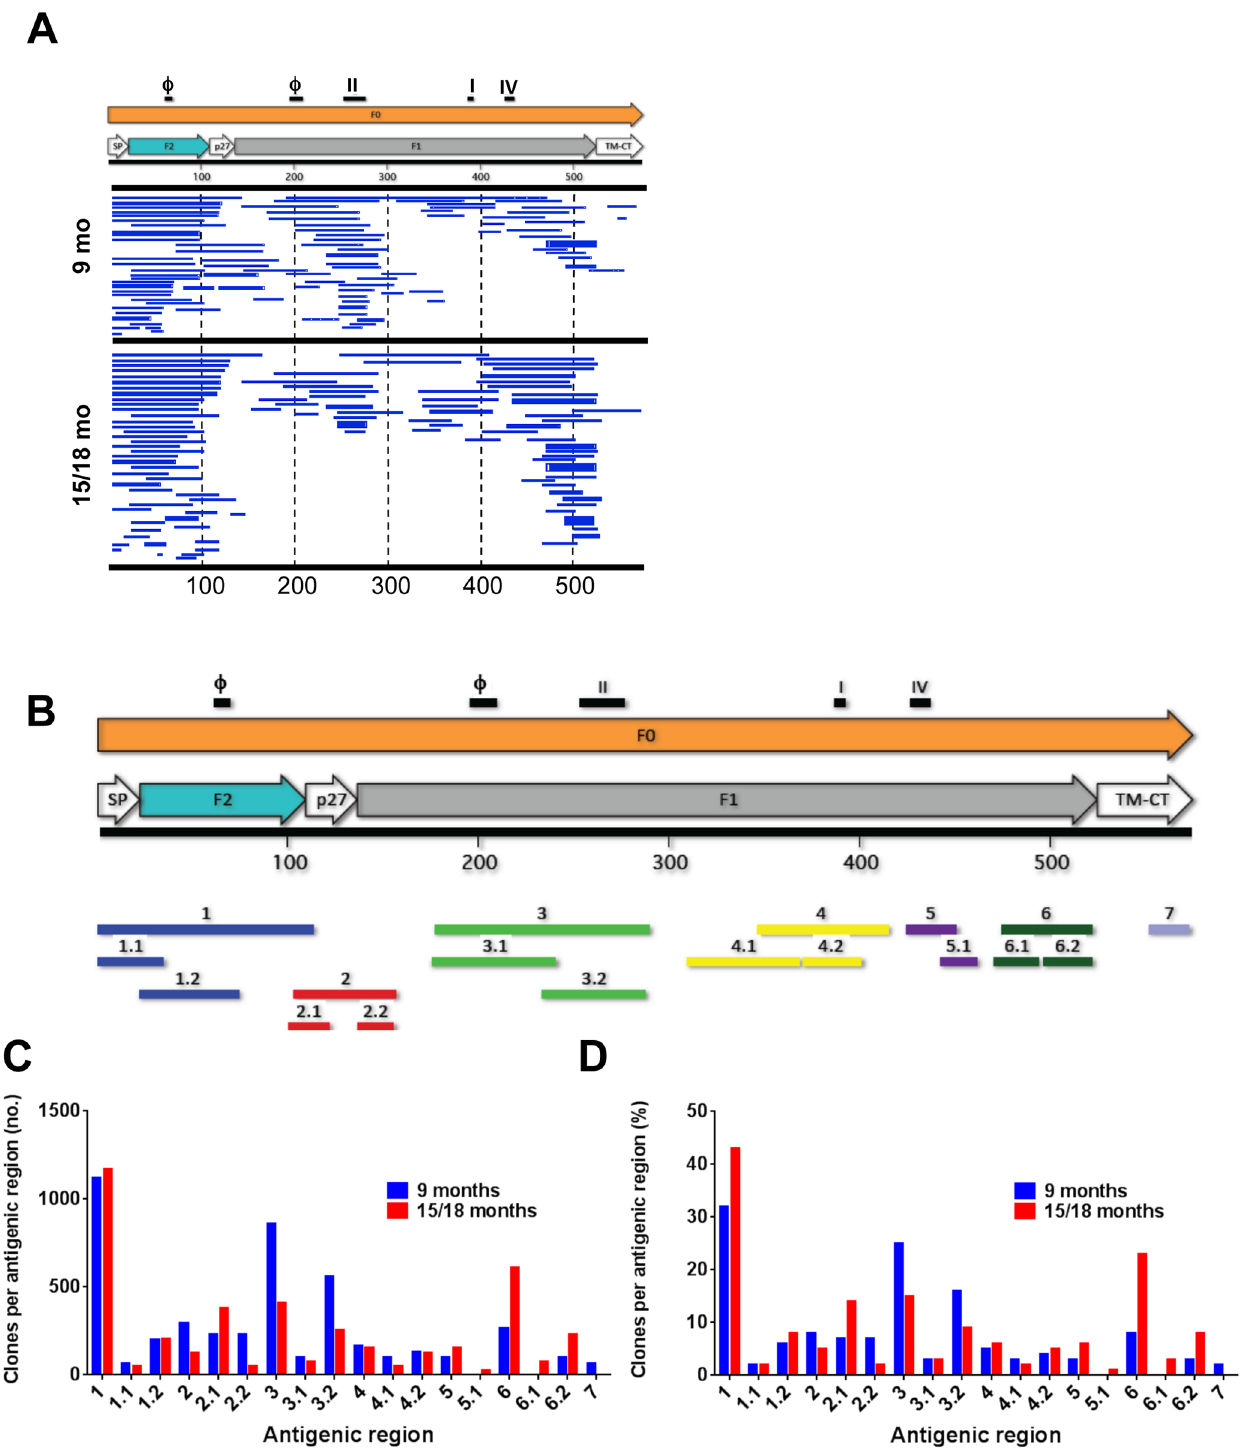
Fig 2. Elucidation of antibody epitope profile against the RSV F protein following RSV primary infection in children. (A) Distribution of phage clones after RSV-F GFPDL affinity selection with sera obtained from children at 9 months (top) or 15 – 18 months of age (bottom). The amino acid designation is based on the RSV-F protein sequence. Bar location indicates the homology of the displayed RSV-F protein sequence on the phage clones after affinity selection. The thickness of each bar represents the frequencies of repetitively isolated phage inserts (only clones with a frequency of two or more are shown). (B) Antigenic sites within the RSV F protein recognized following primary RSV infection. Previously described antigenic sites (sites ϕ , I, II and IV) are